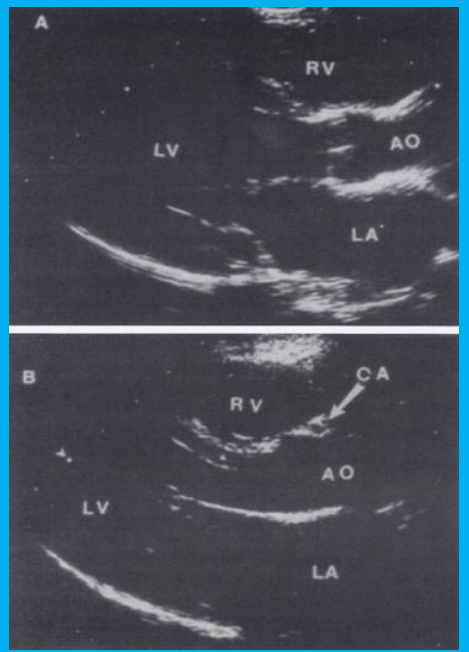
Figure 12. Selected video frames from parasternal long-axis view in a normal child ( A ) and in a child with aberrant coronary artery ( B ): Note a cross-sectional image of the coronary artery (CA) is seen in ( B ) in the anterior wall of the aorta (AO) while such is not seen in ( A ). LA, left atrium; LV, left ventricle; RV, right ventricle. Reproduced from Jureidini S.B., et al. [15].